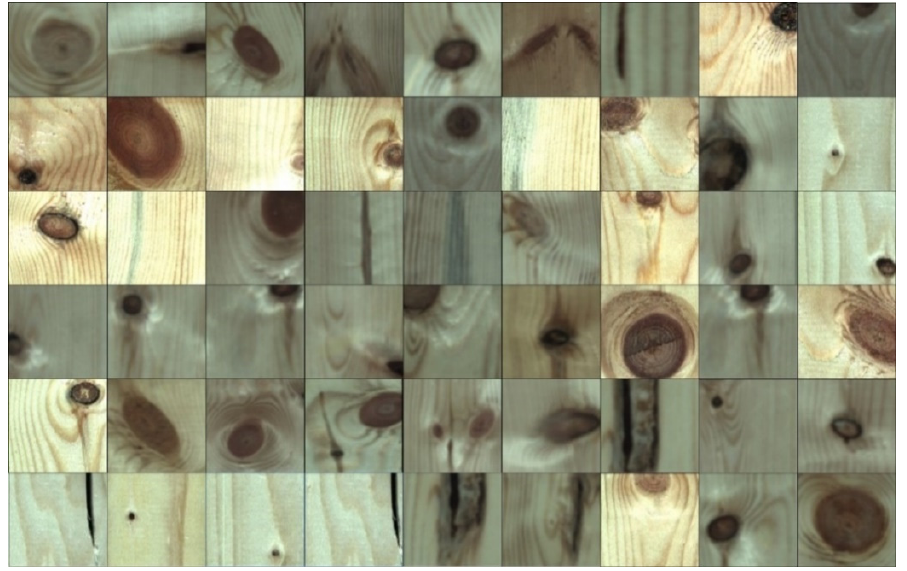
Figure 2. Partial sample images.